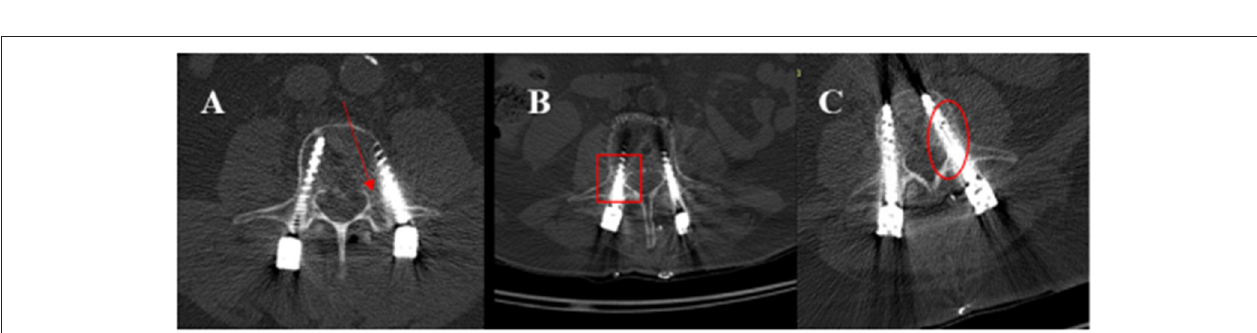
FIGURE 4 | Post-operative CT illustrates the position of the screws according to Rampersaud graduation. (A) The right pedicel demonstrates a grade A position; the screw in the left pedicel shows a D grade (with the red arrow marked). (B) shows the screw in the right pedicel with Grad B pedicle wall breach < 2 mm- (marked with a square). (C) illustrates a screw position in the left pedicel with grade C – the wall of pedicle breach equal to 2–4 mm- (with the circle marked) without neurological symptoms. In these cases, no revision is